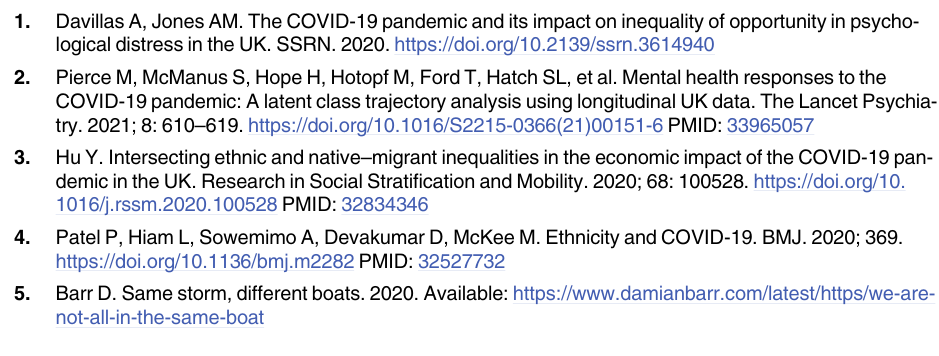
S1 Table. Samples and sample selection. S2 Table. Baseline model: Changes in the five indicators across waves. S3 Table. Gender and period interaction model results. S4 Table. Ethnicity and period interaction models. S5 Table. Education and period interaction model